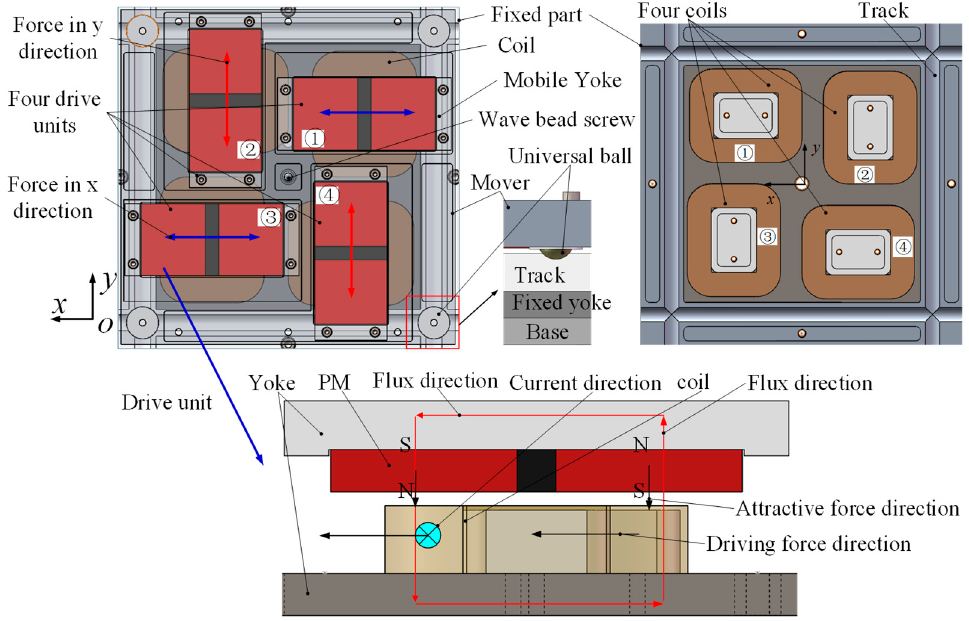
Figure 2. Structure of the electromagnetic conveying platform.